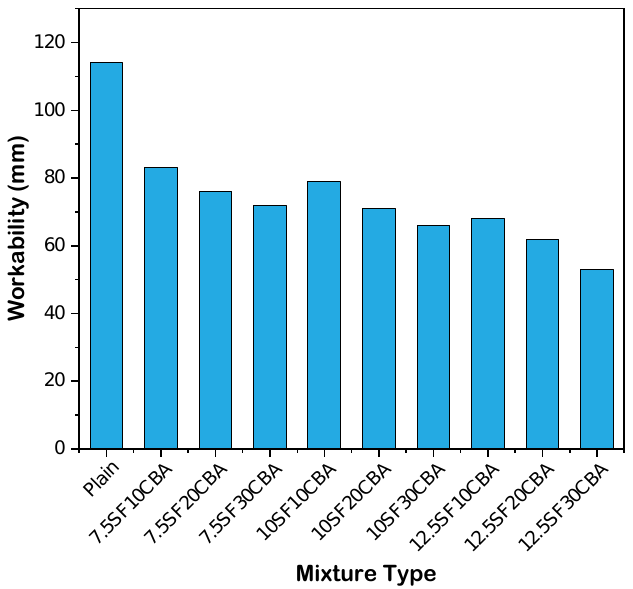
Figure 3. Workability of mixture blended with different percentages of CBA and SF.